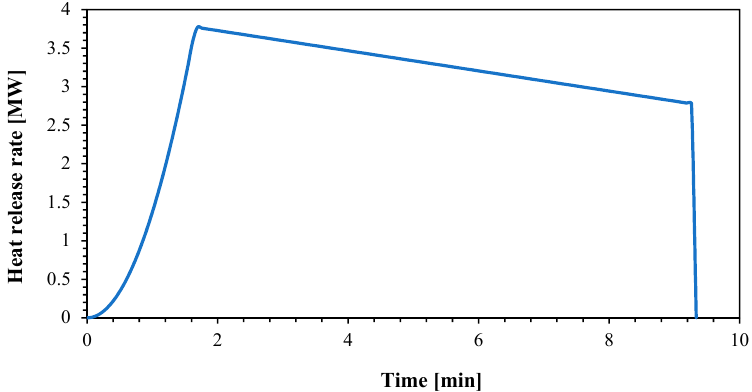
Figure 9. Baseline heat release rate curve for the dwellings used in the 20-dwelling experiment. A soot yield of 0.015 g/g, CO 2 of 1.33 g/g and radiant loss fraction 𝜒 𝑅 of 0.3 were taken from Table 3–4.14 of the SFPE Handbook [20]. The heat of gasification (1.8 kJ/g) was selected from Table 3–4.7 of